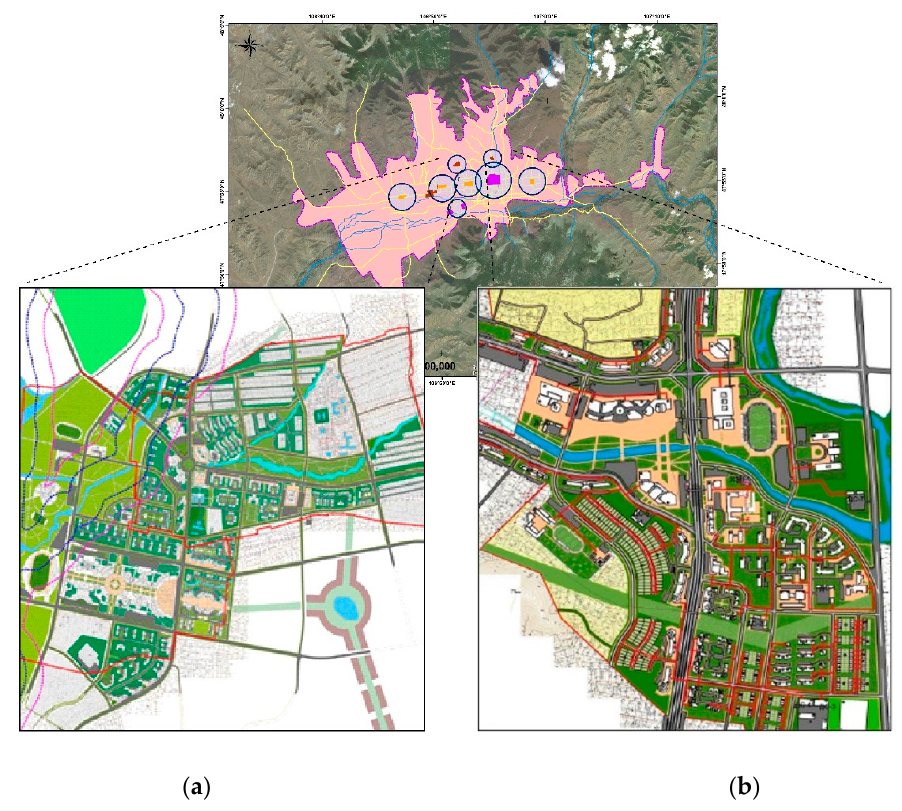
Figure 7. Planned sub-centers. ( a ) Bayankhoshuu sub-center; ( b ) Selbe sub-center.